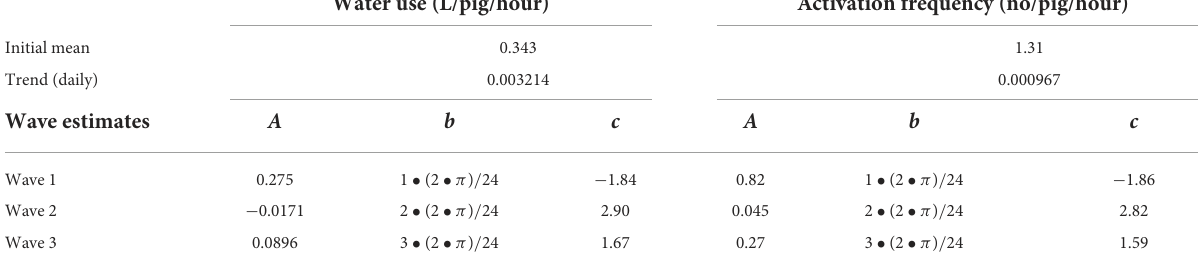
TABLE 2 Estimated values (square root transformed) extracted from the model of the initial mean, daily trend, amplitude ( A ) and phase shift ( c ) of each wave summed to describe the diurnal pattern in water use and activation frequency in finisher pigs. Water use